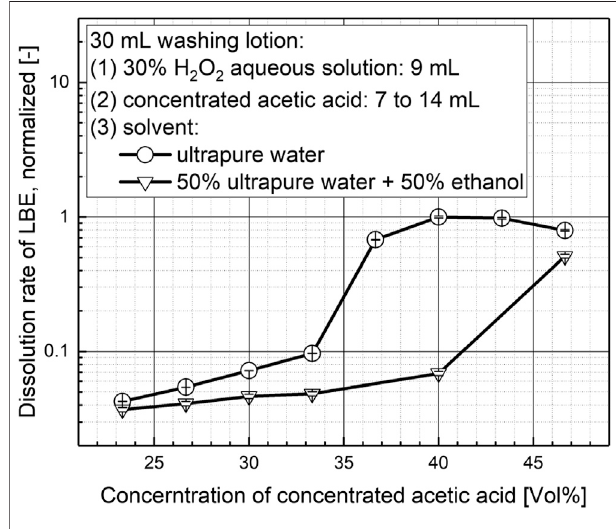
FIGURE3| Therelationshipbetweenthedissolutionrateandthesolvent type: (A) 100% ultrapure water; (B) 50% ultrapure water + 50% ethanol.